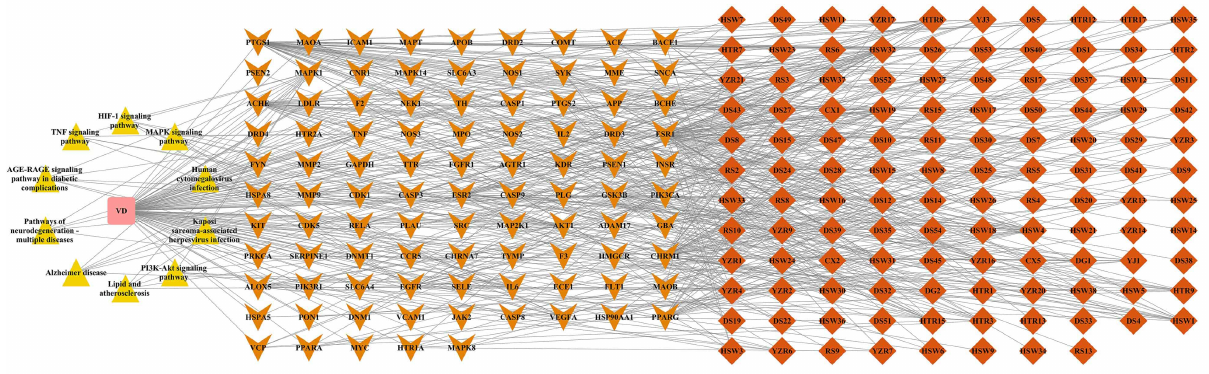
Fig. 4. The diagrams of KEGG pathway enrichment analysis. (A) The histogram of KEGG pathway enrichment analysis. The letters on the left of the graph are the names of KEGG pathways, and the numbers below are the number of genes enriched on KEGG. The bar graph represents the pathways enriched on KEGG, and p represents the significance of enrichment. The redder the color, the higher the degree of enrichment, and the smaller the corresponding p -value. (B) The bubble diagram of KEGG pathway enrichment analysis. The principle is the same as the histogram.